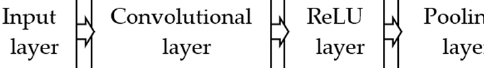
Figure 8. CNN model.